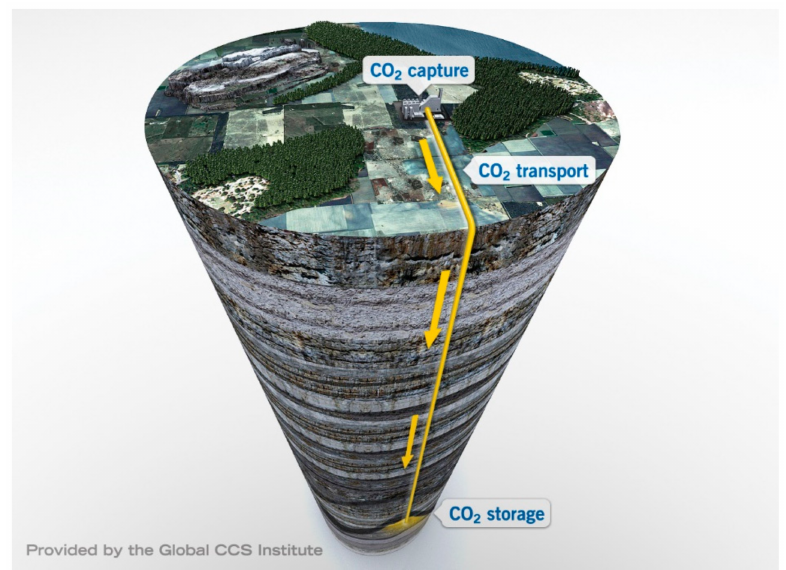
Figure 1. Schematic showing the process of carbon capture, transport and storage. Figure courtesy of the Global CCS